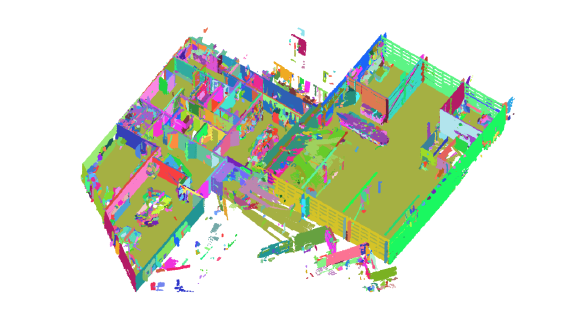
Figure 2: Surface growing planar segmentation. Each segment is represented by a vertex in the graph. Colors are